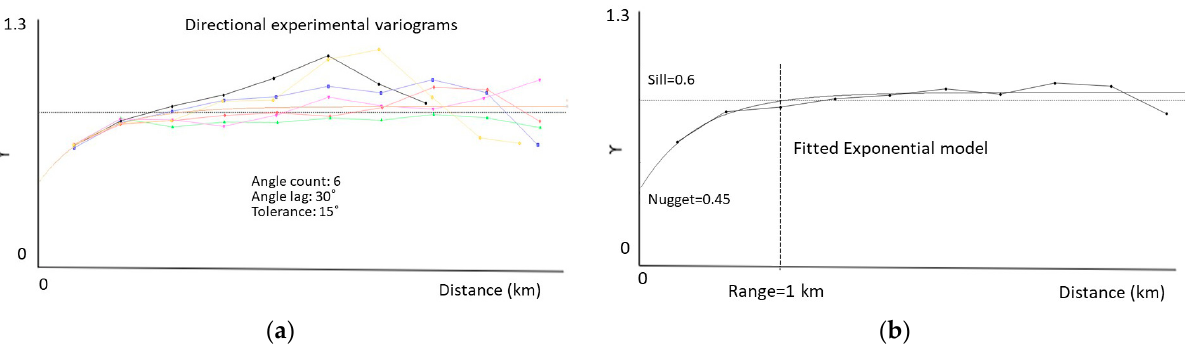
Figure 5. ( a ) Directional variograms (angle lag 30°; tolerance 15°); and ( b ) adopted omnidirectional variogram. highest productivities of timber (for fully-mature 35 year old trees) in the coastal center regions followed by the northern and central montane and submontane regions (Figure 6).